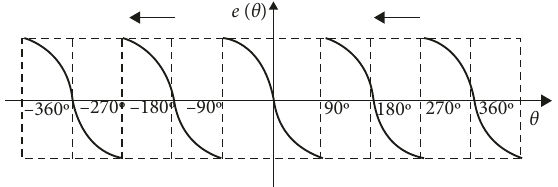
Figure 6: Change rule chart of e ( θ ) when ball screw is moving in a negative